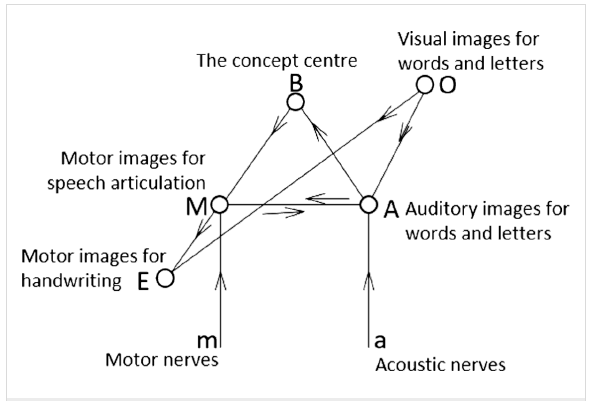
Figure 1: Wernicke’s-Lichtheim model (redrawn from [12], Figure 2). A: The Wernicke’s area. M: The Broca’s area. a: The pathway connecting Broca’s area and the motor nerves. m: The pathway connecting the acoustic nerves and Wernicke’s area.